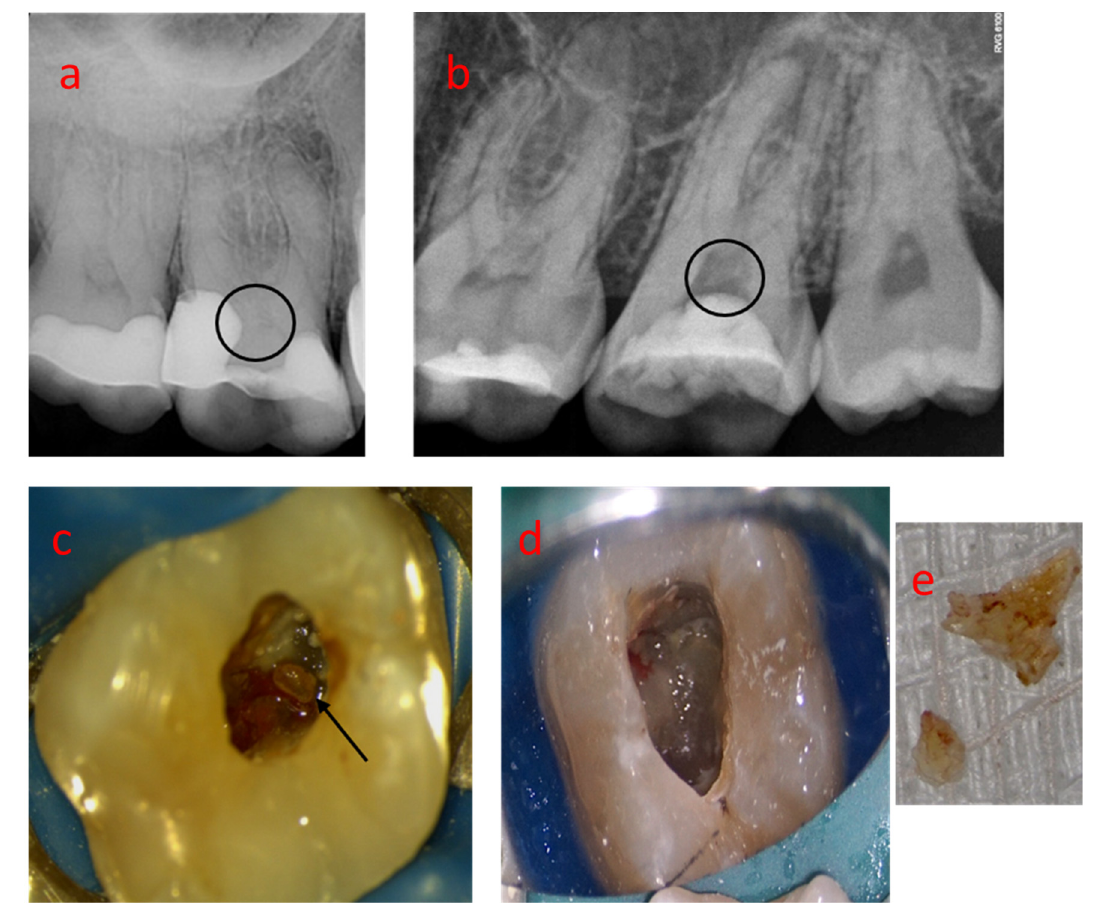
Figure 1. ( a , b ) Preoperative radiographs displaying dental pulp nodules within upper molars’ coronal pulp; ( c ) Pulp nod- ules visible during access (arrows); ( d , e ) A diffuse pulp nodule in a pulp cavity and after the removal.